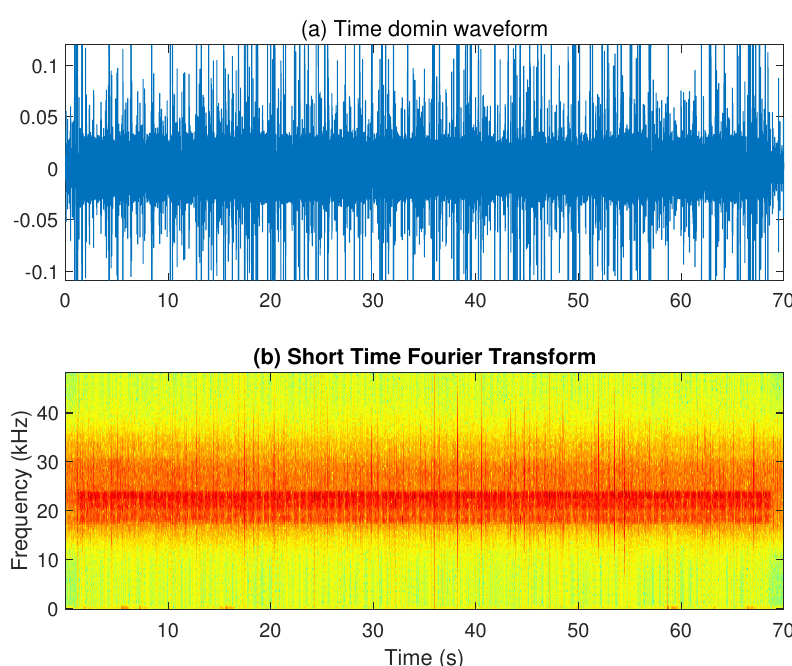
Figure 9. The received signal: ( a ) time domain and ( b ) time frequency